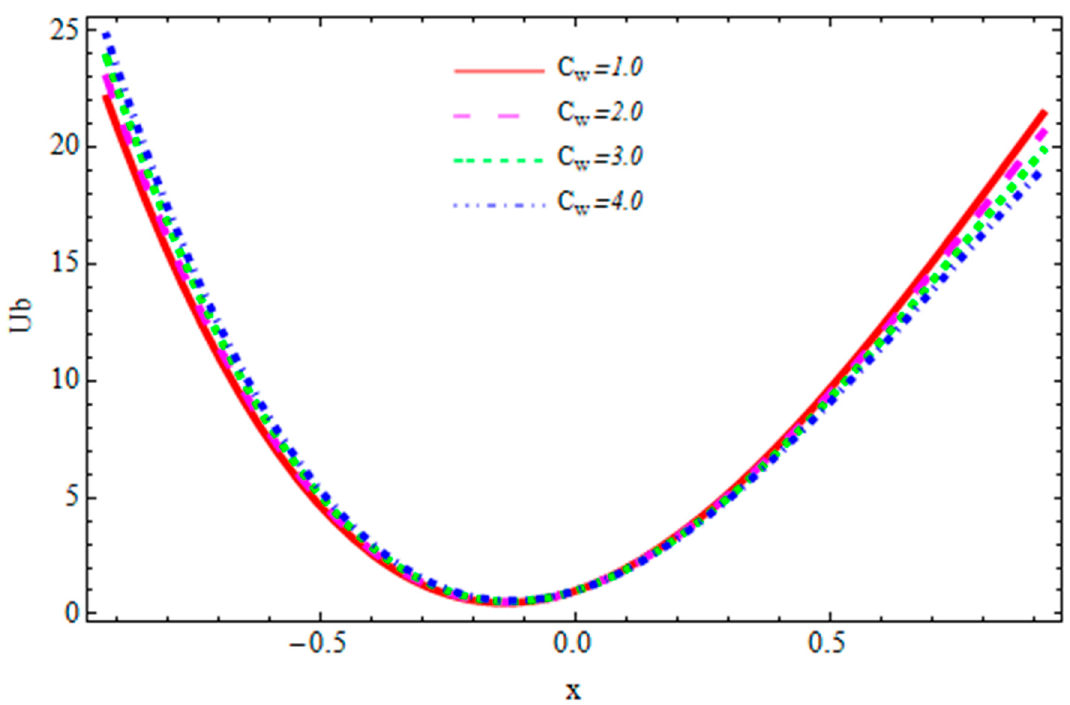
Figure13. Bubblevelocitycurvesforseveralvaluesof C w . R be = 10, V b = 1.0, E o = 1.0, C am = 1.0, W s = 10, Figure 13. Bubble velocity curves for several values of 𝐶 (cid:3050) . R (cid:2912)(cid:2915) = 10,𝑉 (cid:3029) = 1.0,𝐸 (cid:3042) = 1.0,𝐶 (cid:3028)(cid:3040) = 1.0,𝑊 (cid:3046) = Figure 13. Bubble velocity curves for several values of 𝐶 (cid:3050) . R (cid:2912)(cid:2915) = 10,𝑉 (cid:3029) = 1.0,𝐸 (cid:3042) = 1.0,𝐶 (cid:3028)(cid:3040) = 1.0,𝑊 (cid:3046) = and C l = 10, and 𝐶 (cid:3039) = 10. 10, and 𝐶 (cid:3039) = 10.